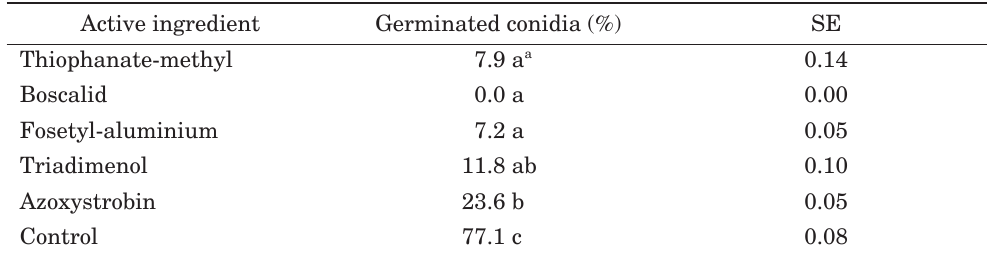
Table 3. Mean percentages of germinated conidia of Seiridium cardinale after 24 h at room temperature in 2% ME amended with one of each fungicide. The control was non-amended 2% ME. Mean values with different letters were significantly different ( P <0.01) according to the AnOVA one-way HSD test.